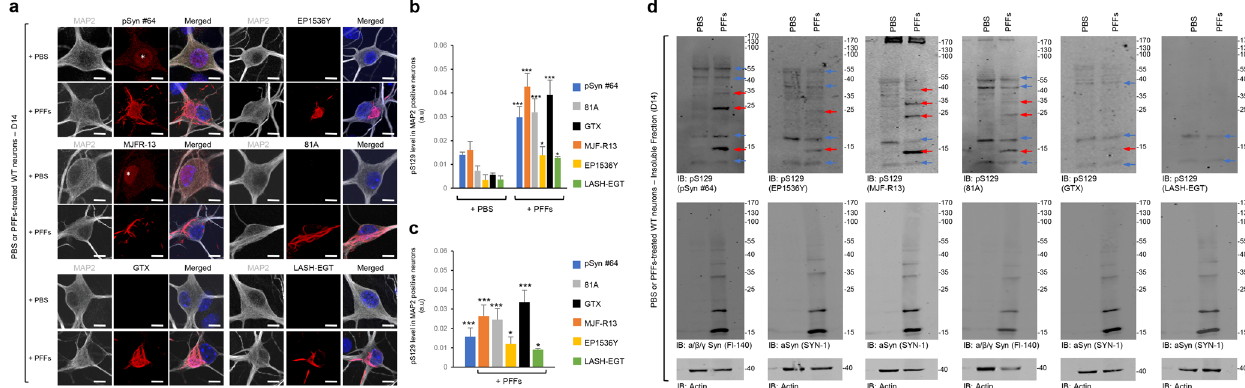
Fig. 4 Assessment of pS129 antibodies detection in the PFFs-seeded WT primary hippocampal neurons. After 14 days of treatment with 70 nM of mouse aSyn PFFs or PBS buffer (negative control), primary hippocampal neurons were fi xed or lysed, and ICC ( a – c ) or WB ( d ) analyses were performed using pS129 antibodies (pSyn#64, MJF-R13, 81A, EP1536Y, and GTX or LASH-EGT). a – c Newly formed fi brils were detected by confocal imaging ( a ) and quanti fi ed by a high-throughput wide- fi eld cell imaging system as previously described 35 . b , c Neurons were counterstained with MAP2 antibody and the nucleus with DAPI staining. Scale bar = 10 μ M. b The left-hand side part of the histogram shows the background of each pS129 antibody in PBS-treated primary neurons, while the right-hand side part of the histogram shows the pS129 level detected by the pS129 antibodies in PFFs-treated primary neurons. c pS129 level in PFF-treated primary neurons was re-evaluated after subtracting the pS129 background level from the PBS-treated neurons. The graphs represent the mean + / − SD of three independent experiments. * p < 0.01, *** p < 0.0001 (ANOVA followed by Tukey HSD post hoc test, PBS vs. PFF-treated neurons). d WB analyses of the insoluble fractions of the PBS- and PFF-treated neurons. Membranes were then counterstained by total aSyn antibodies (SYN-1 or Fl-140 α / β / γ synuclein), and actin was used as a loading control. The red arrows indicate the pS129-aSyn positive bands. The blue arrows indicate the unde fi ned bands. All blots were derived from the same experiment and were processed in